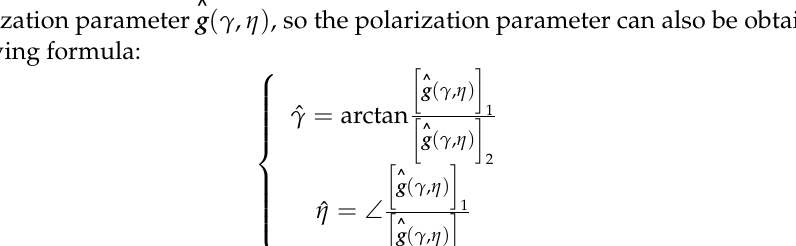
Table 1. Relative dielectric constant ε r and surface material conductivity σ e under different terrains. Index Dielectric Relative Permittivity 1 Good soil (wet soil) 25 0.02 2 General soil 15 0.005 3 Poor soil (dry soil) 3 0.001 4 Snow and ice 3 0.001 5 Freshwater 81 0.7 6 Seawater 75